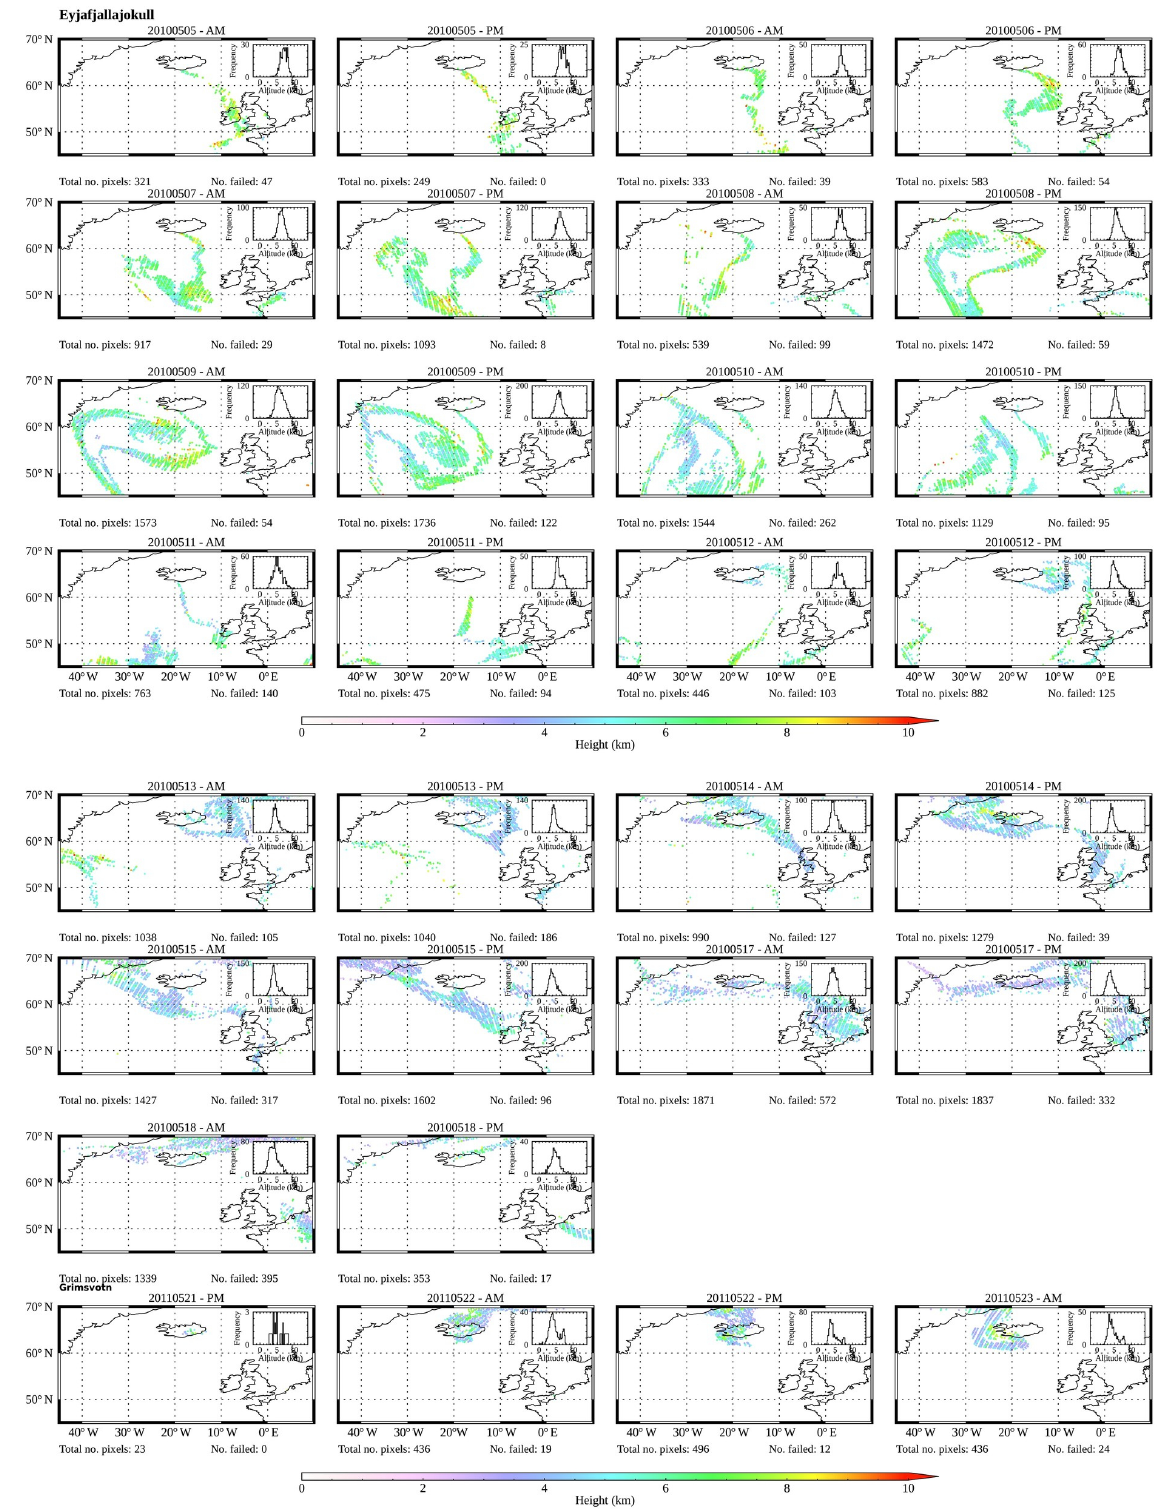
Figure 7. Maps of the CO 2 slicing output (with quality control applied) for the Eyjafjallajökull and Grímsvötn eruptions. Each plot consists of multiple orbits, divided into morning and afternoon. On each plot is a histogram showing the distribution of heights for each scene. Beneath each plot are numbers showing the total number of pixels in each image and the number of pixels for which the CO 2 slicing method was unable to return a